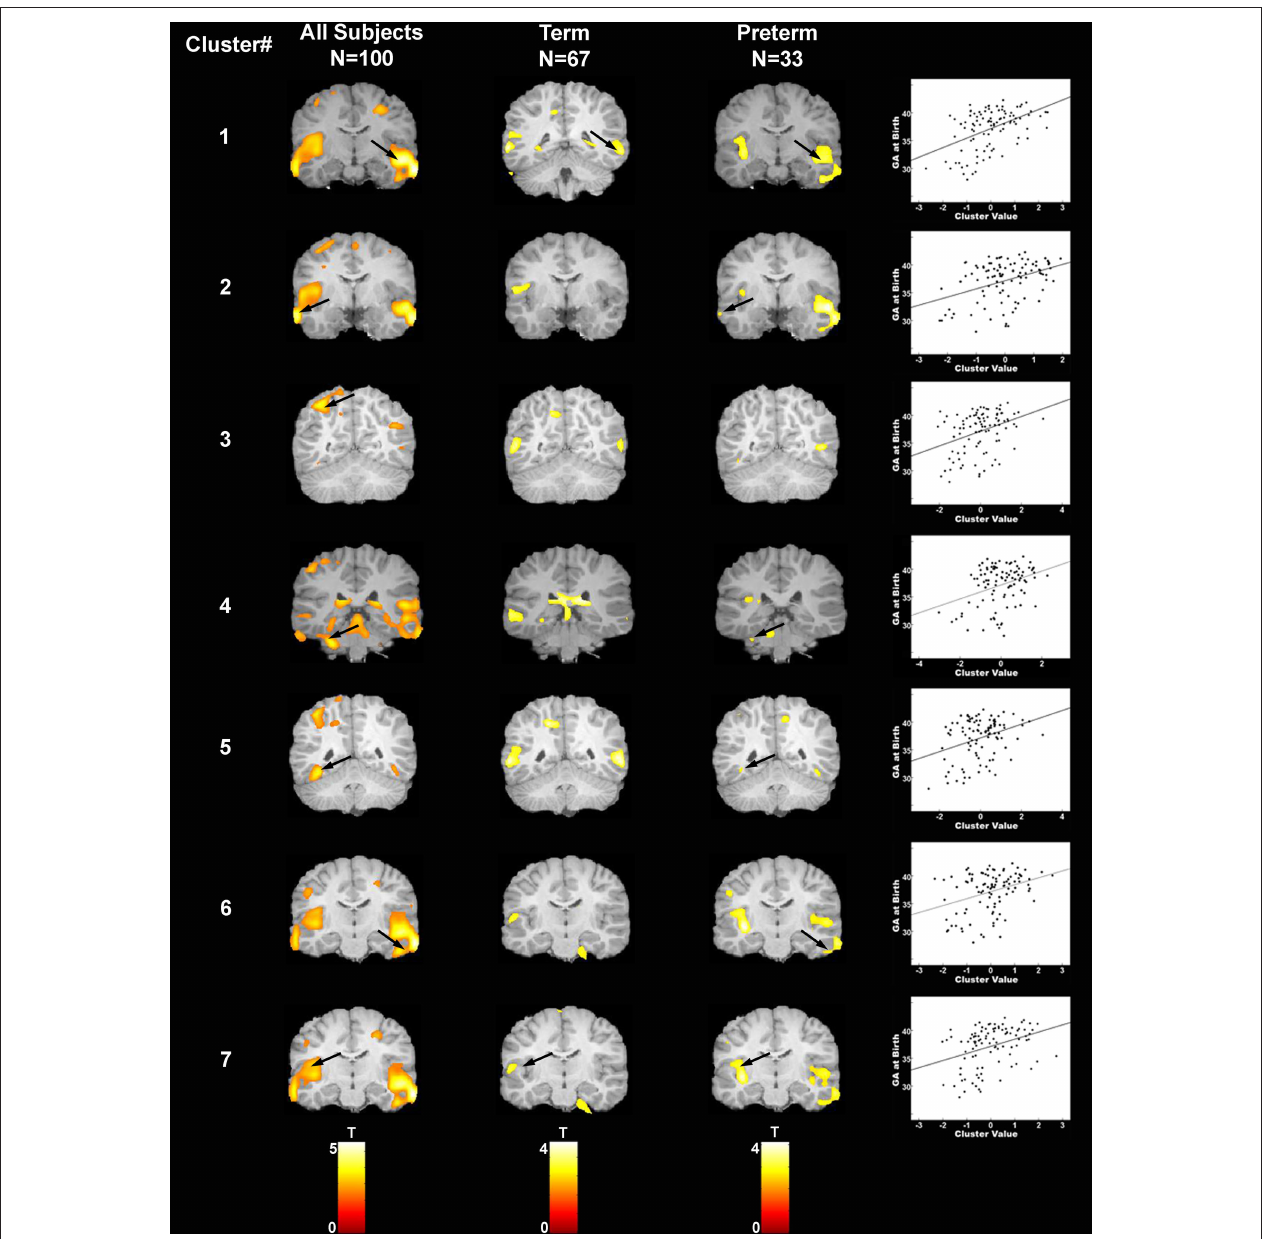
FIguRe 2 | Areas of increased gray matter density in association with longer gestation are displayed for each of the seven regions of interest for: (i) the complete sample (column 1), (ii) children born at term (column 2), and (iii) children born preterm (column 3). Arrows indicate clusters that were significantly associated with gestational age at birth after correction for multiple comparisons. Scatter plots are presented for illustrative purposes only to demonstrate the linear nature of the association between gestational age at birth